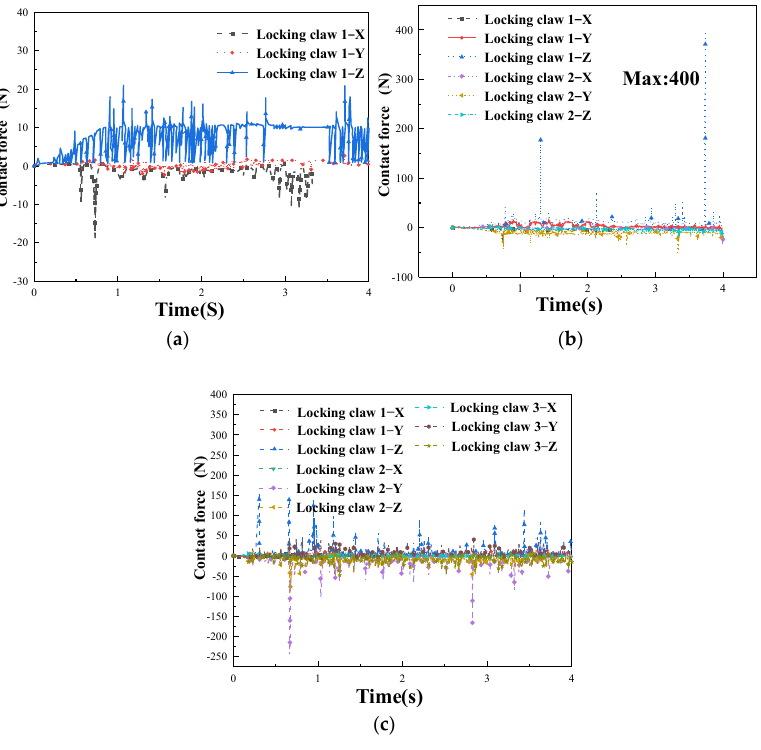
Figure 13. Contact force of locking jaws. ( a ) An effective locking point ( b ) Two effective locking points ( c ) Three effective locking points.